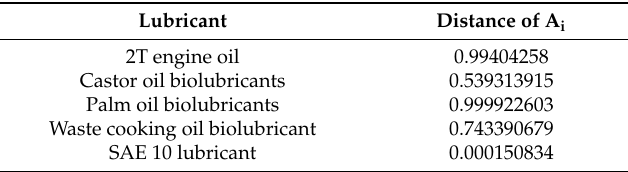
Table 9. Distance of A i from the positive and negative ideal